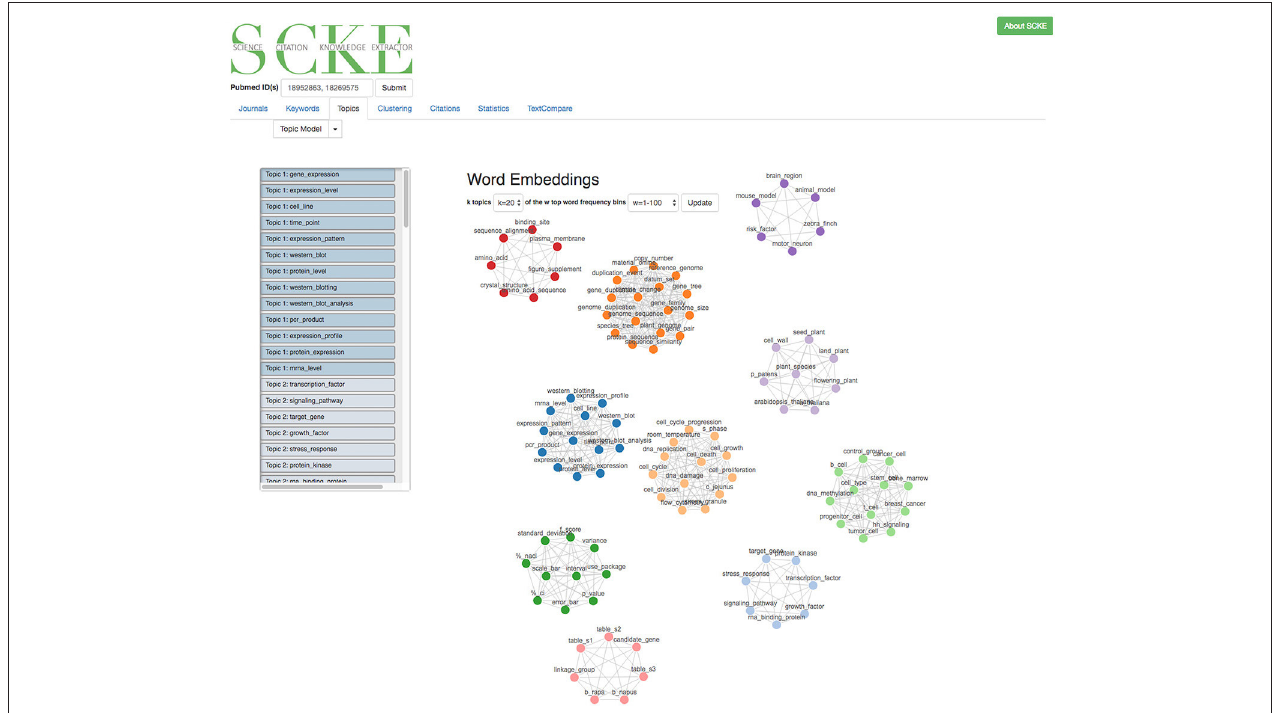
FIGURE 8 | An example of a visualized topic model that a user would see. Words pertaining to a topic are visualized as cluster. A list of topic words is also provided on the left. Users can generate new topic models with a varying number of topics and with different word frequency restraints.